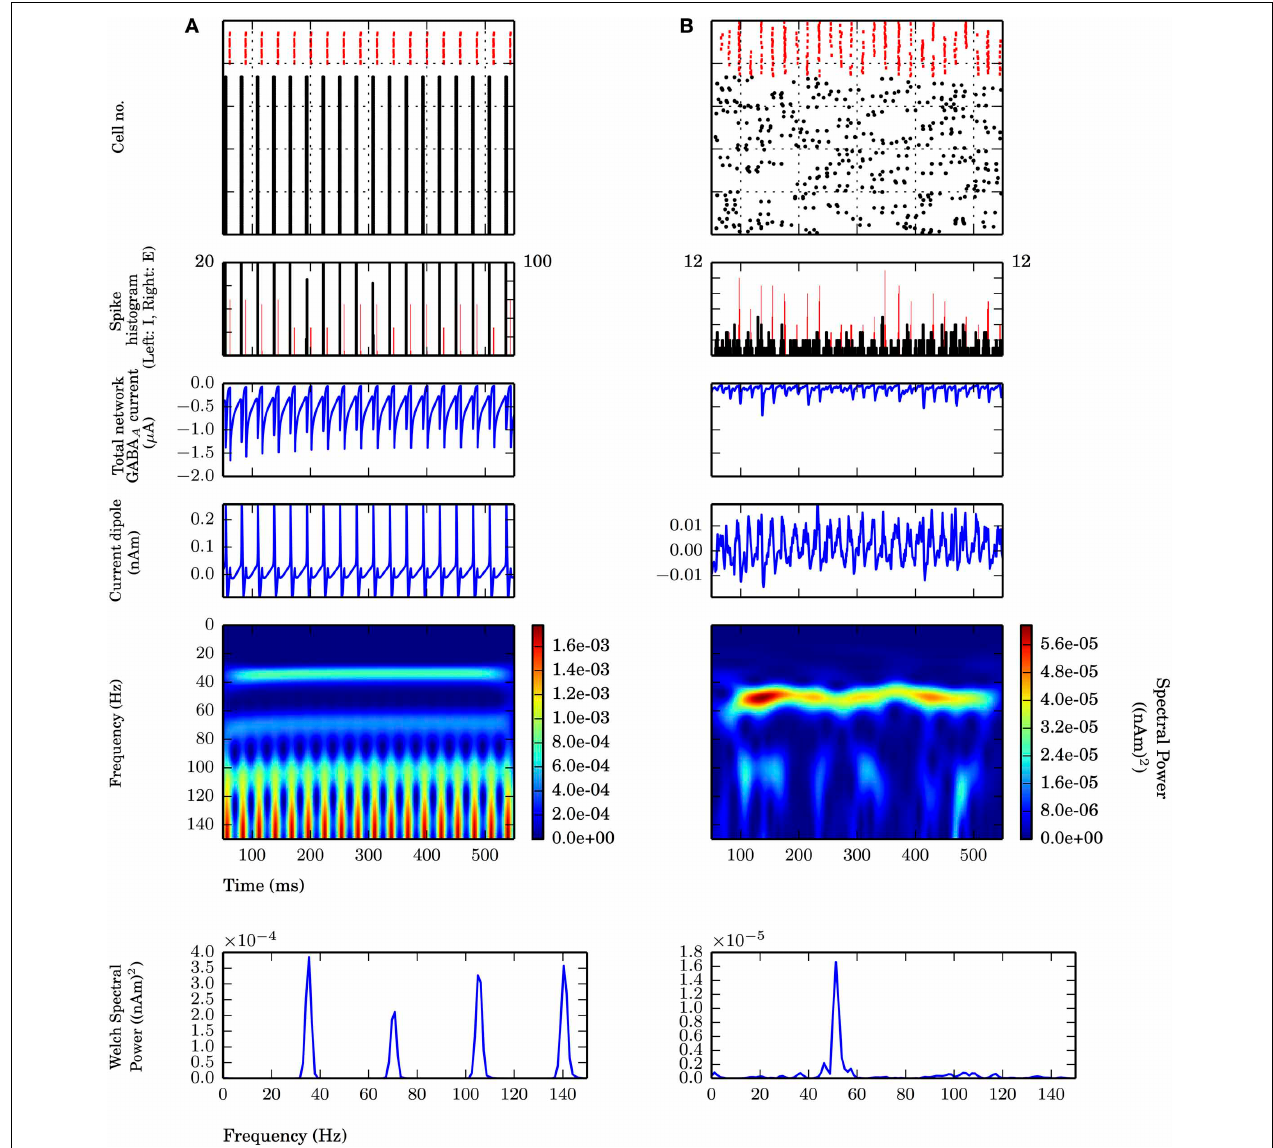
FIGURE 2 | Strong PING and weak PING rhythms have characteristically different current dipole waveforms. Simulations from L5 network consisted of 100 E cells and 35 I cells, synaptically connected as described in Methods. From top panel to bottom: spike raster of E cells (black) and I cells (red); spike histogram of E cells (black, right scale) and I cells (red, left scale), 1ms bins; aggregate GABA A -ergic current contribution to E cell somata ( μ A); network current dipole (nAm); Morlet spectrogram of current dipole; stationary Welch periodogram for current dipole. Simulations shown from 50 to 550ms. (A) Strong PING oscillations with all pyramidal cells spiking on each cycle of the oscillation